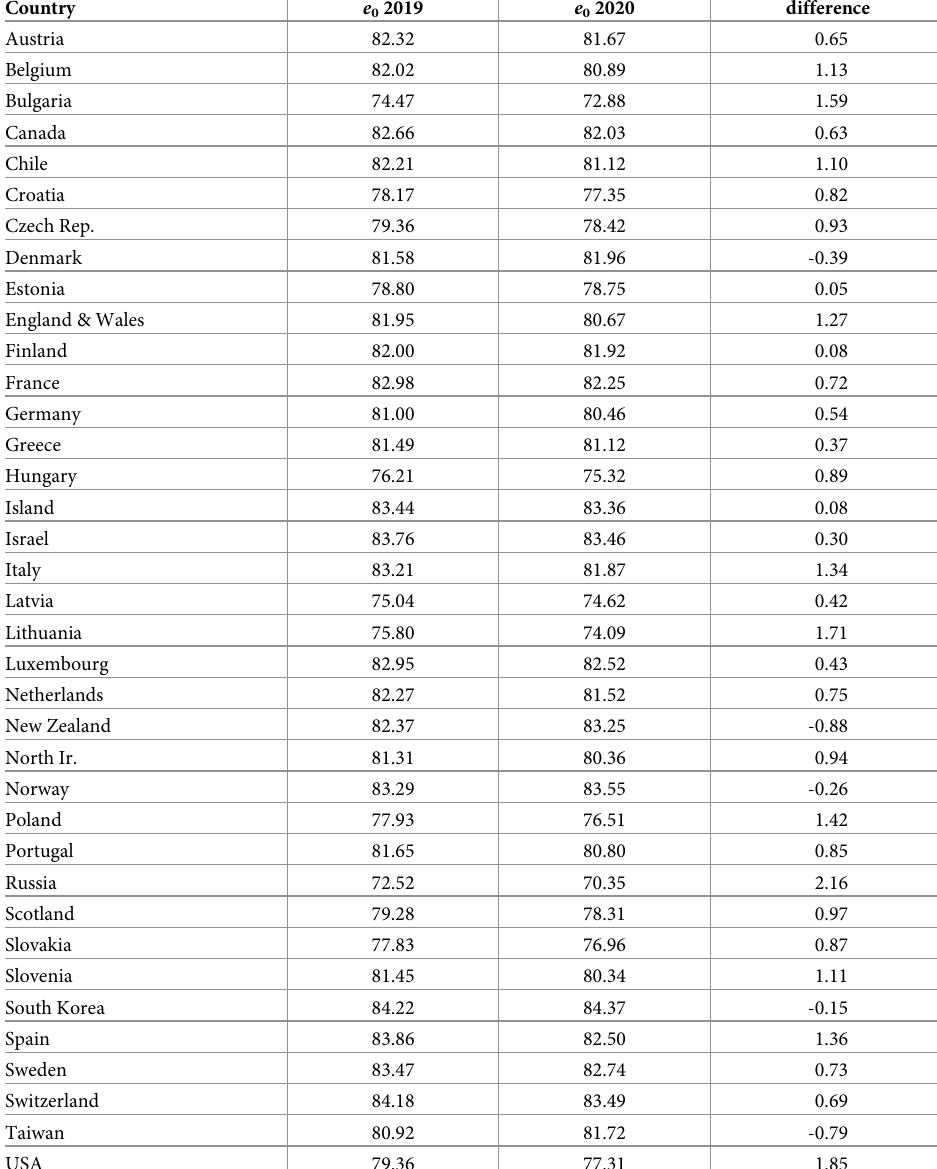
Table 1. Life expectancy at birth in 2019 and 2020 for several countries. Elaborations from the Human Mortality Database.